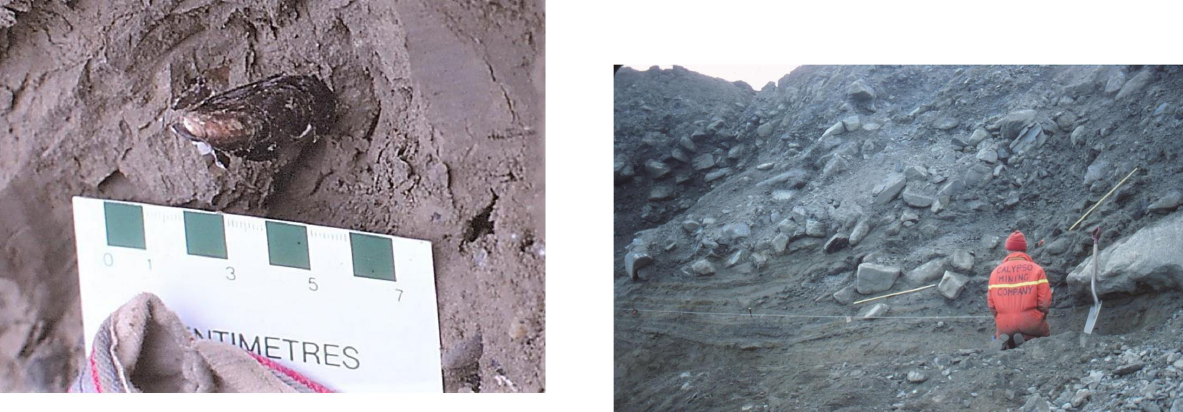
Figure 12. The upper half of the photo shows the extremely coarse foresets in Formation 4 at Skilvika. Note how the foresets in- terfinger with the sand and gravel beds in Formation 3.